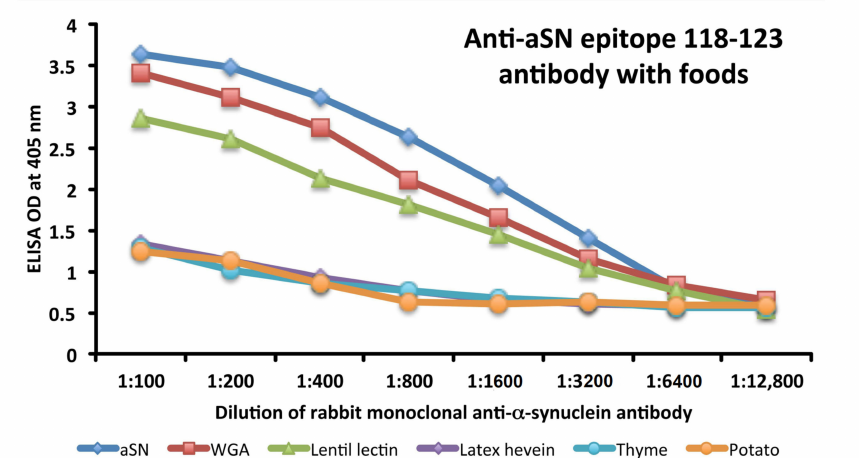
Figure 4. Analytical specificity by serial dilution study for rabbit monoclonal anti-aSN epitope 118-123. Shown are the reactions of various dilutions of rabbit monoclonal anti-aSN antibody with alpha-synuclein (blue diamond), WGA (red square), lentil lectin (green triangle), latex hevein (purple diamond), thyme (light blue circle) and potato (orange circle). aSN—alpha-synuclein, WGA –wheat germ